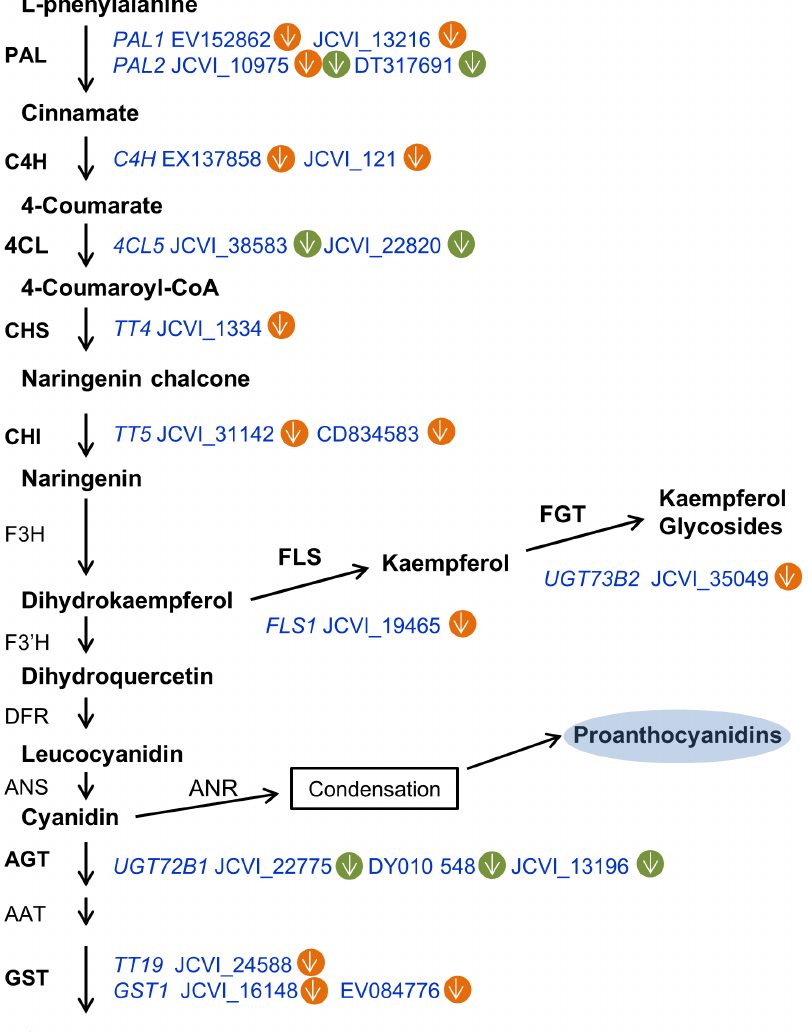
Figure 5. Differentially expressed genes involved in flavonoid and phenylpropanoid synthesis. The green circle represents SW, and the yellow circle indicates seed. Arrows pointing up show increased expression; arrows pointing down show decreased expressions. Abbreviations: PAL, phenylalanine ammonia lyase; C4H, cinnamate 4-hydroxylase; 4CL, 4-coumarate-CoA ligase; CHS, chalcone synthase; CHI, chalcone isomerase; F3H, flavanone 3-hydroxylase; F 9 3H, flavonoid 3 9 -hydroxylase; FLS, flavonol synthase; FGT, flavonol glycosyltransferase; DFR, dihydroflavonol 4-reductase; ANS, anthocyanidin synthase; AGT, anthocyani(di)n glycosyltransferase; AAT, anthocyanin acyltransferase; GST, glutathione S-transferase; ANR, anthocyanidin reductase. This scheme was based on the analysis by Lillo et al. (2008)